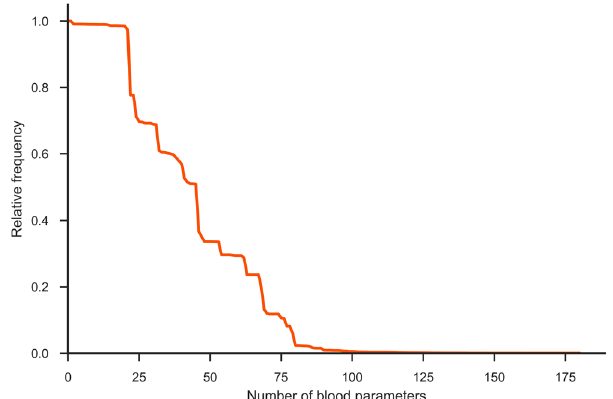
Figure 2. Missing data. Blood parameters ordered by decreasing relative frequency. Most parameter values 75.1% are unknown (missing).